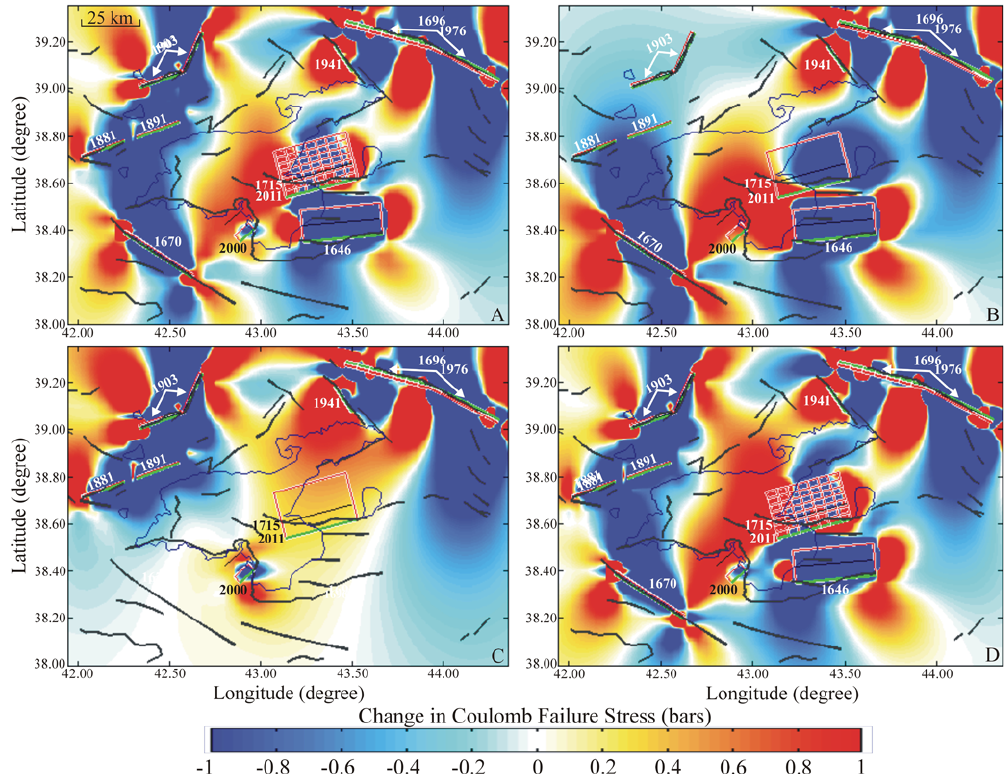
Fig. 5. Maps of Coulomb stress changes due to the background seismicity in the Lake Van area before and after the 23 October 2011 Van earthquake. The stress changes due to (a) all earlier earthquakes, (b) the earthquakes before 1715 Van earthquake and (c) the earthquakes after 1715 and before 2011 have been resolved onto the 2011 Van earthquake’s fault plane (strike 255 ◦ , dip 50 ◦ , rake 73 ◦ ) . (d) The stress changes following the 2011 Van earthquake calculated over the 1646 Van earthquake’s fault, the G¨urpınar fault (strike 265 ◦ , dip 50 ◦ , rake 73 ◦ ) . See Table 4 for the list of earthquakes in the background seismicity and their rupture parameters and the caption of Fig. 2 for the active fault